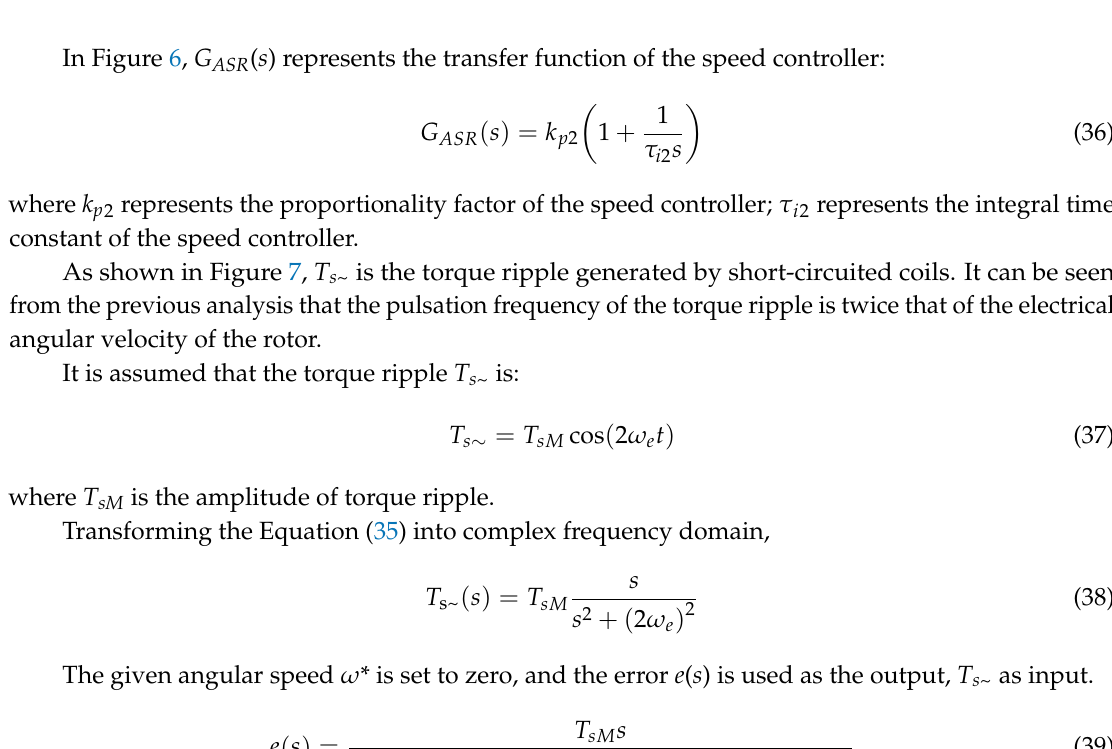
Figure 6. The transfer function of speed loop.